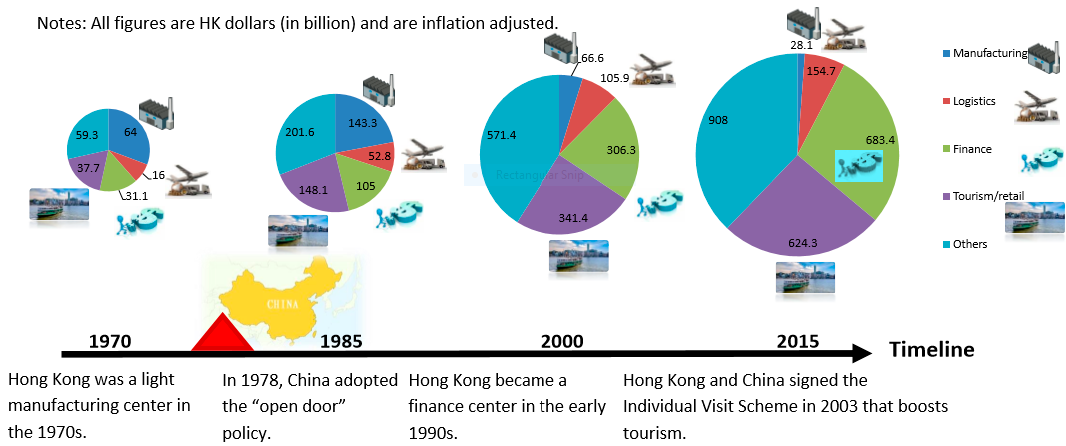
Figure 1. An infographic showing the economic change in Hong Kong for the period from 1970 to 2015.